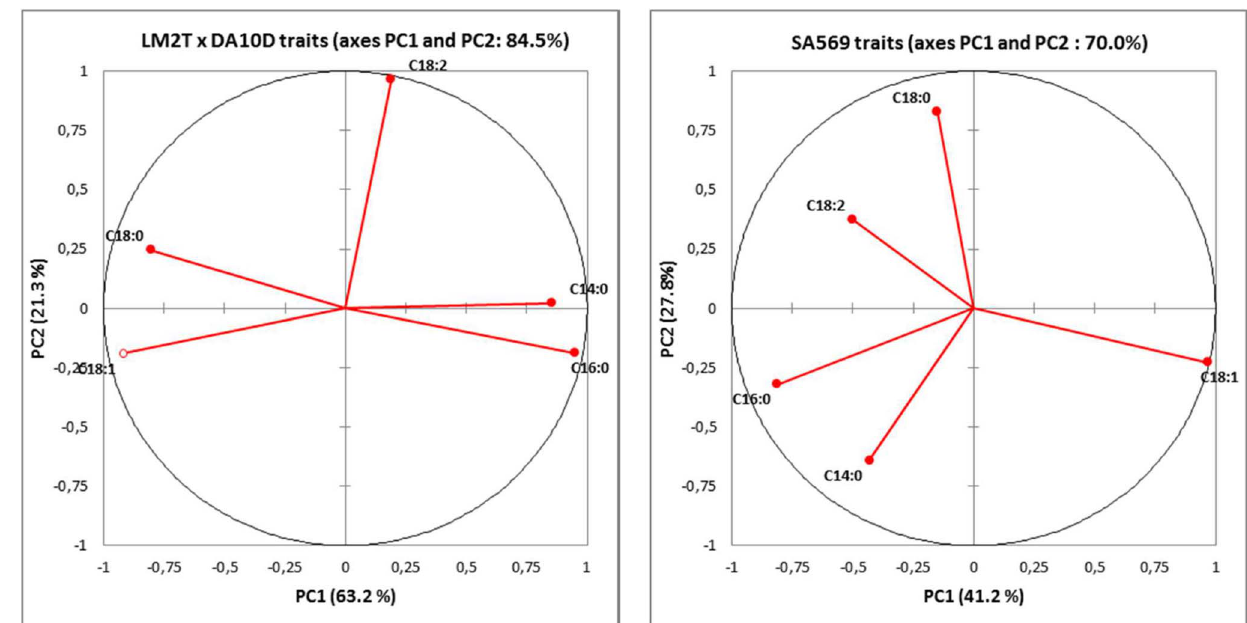
Figure 1. Principal component analysis (PCA) of palm oil fatty acid proportions of C14:0, C16:0, C18:0, C18:1 and C18:2 in the intraspecific cross LM2T x DA10D and in the interspecific pseudo-backcross SA569. Note: the figure show projections on the two first axes of the PCA.